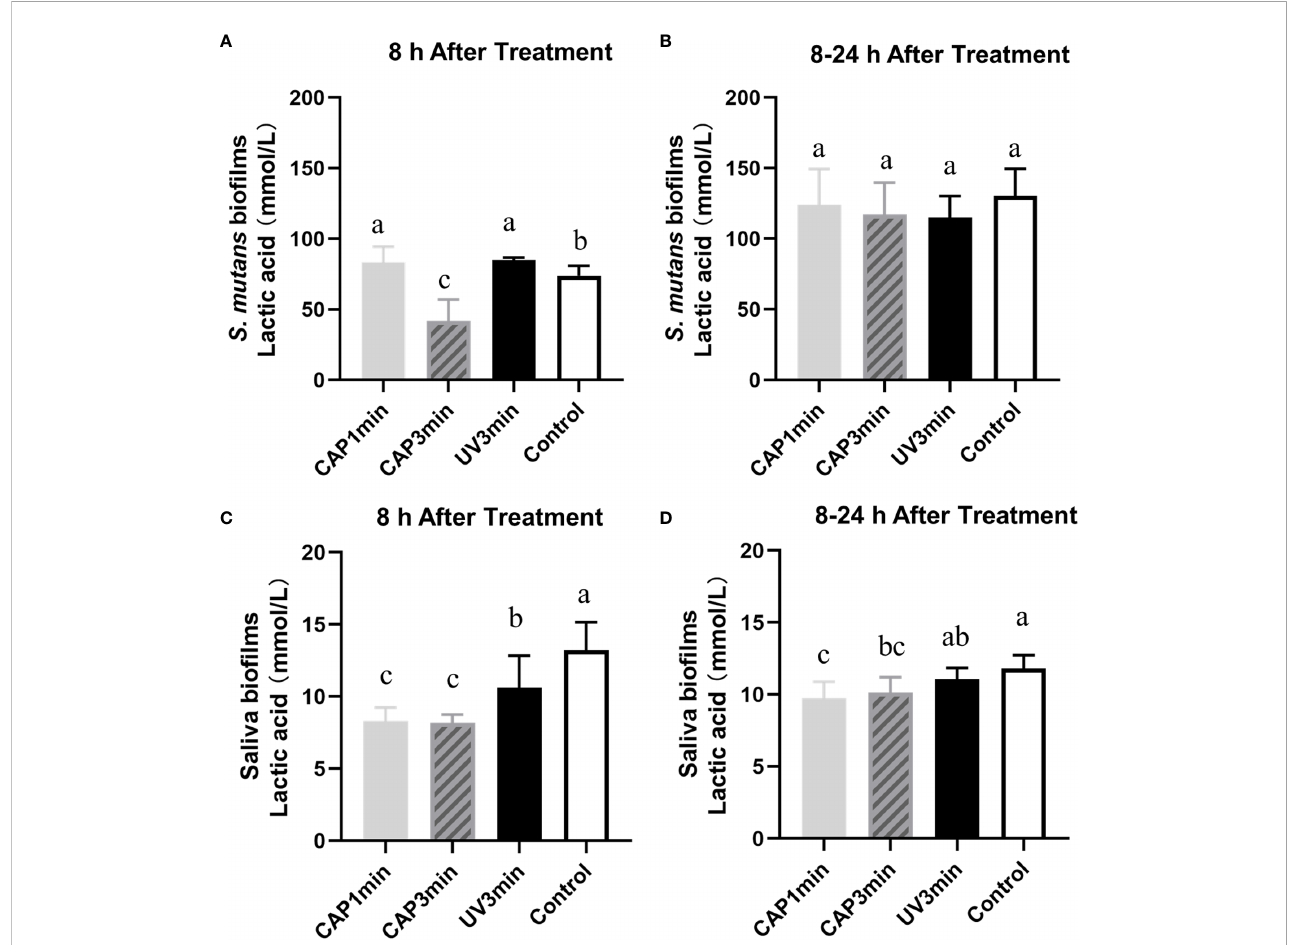
FIGURE 7 Lactic acid production of Streptococcus mutans bio fi lms (A, B) or saliva bio fi lms (C, D) at different times. A&C. The fi rst 8 h after treatment. B&D. 8 – 24 h after treatment. Dissimilar letters indicate statistical differences between groups ( P <